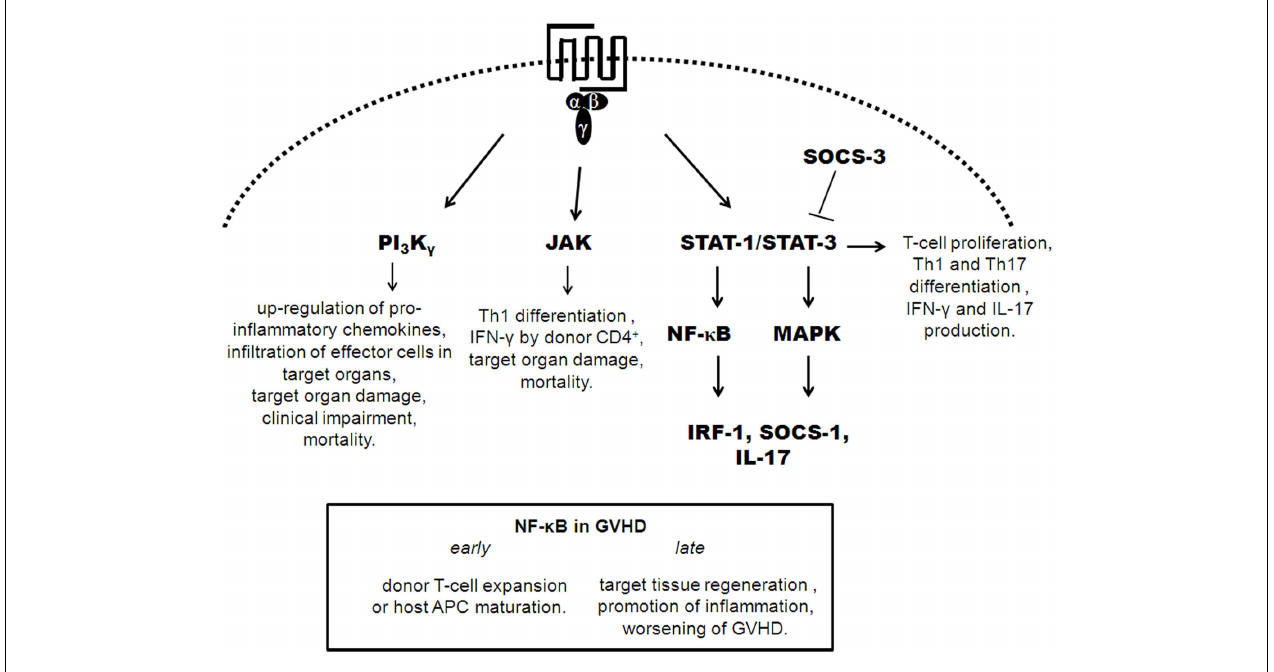
activation preceded the activation of NF- κ B and MAP kinases with the subsequent expression of IRF-1, SOCS-1, and IL-17. NF- κ B has a dual role in development of GVHD, depending of phase of it expression. STAT-3 phosphorylation acts as a promoter of GVHD inflammation and is regulated by